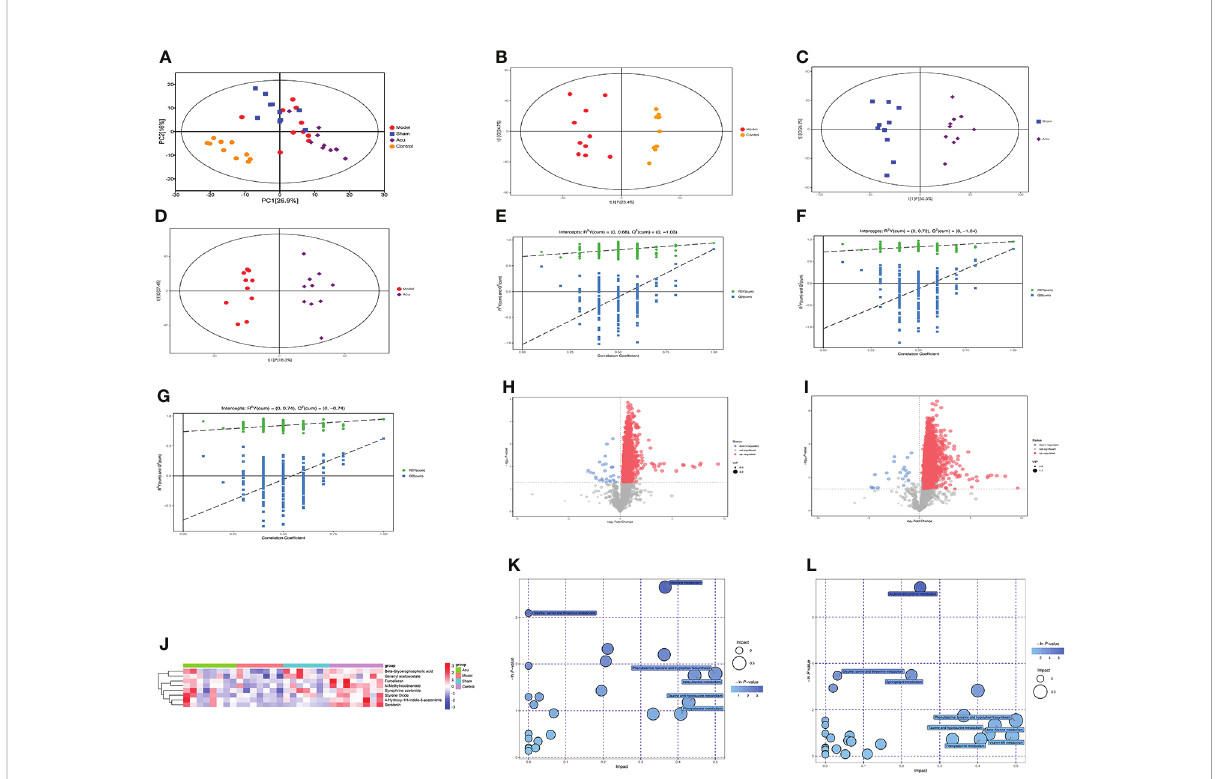
FIGURE 5 Acupuncture treatment modulates serum metabolites and metabolic pathways changes of CRF mice after chemotherapy for BC. (A) PCA was used to detect trends and outliers in the serum metabolome between groups. (B) Scores plots of OPLS-DA between the model and control groups. (C) Scores plots of OPLS-DA between the sham and acu groups. (D) Score plots of OPLS-DA between the model and acu groups. (E – G) The corresponding coef fi cient of loading plots between the model and control groups, sham and acu groups, and model and acu groups. (H, I) Volcano plot of the acu and model groups and acu and sham groups, where each point represents a metabolite. Red dots represent up- regulated metabolites, blue dots represent down-regulated metabolites. (J) Main differential metabolites between groups screened by VIP value and P value. (K) The related pathways screened out by comparing the model group and the control group. (L) The related pathways screened out by comparing the acu group and the model